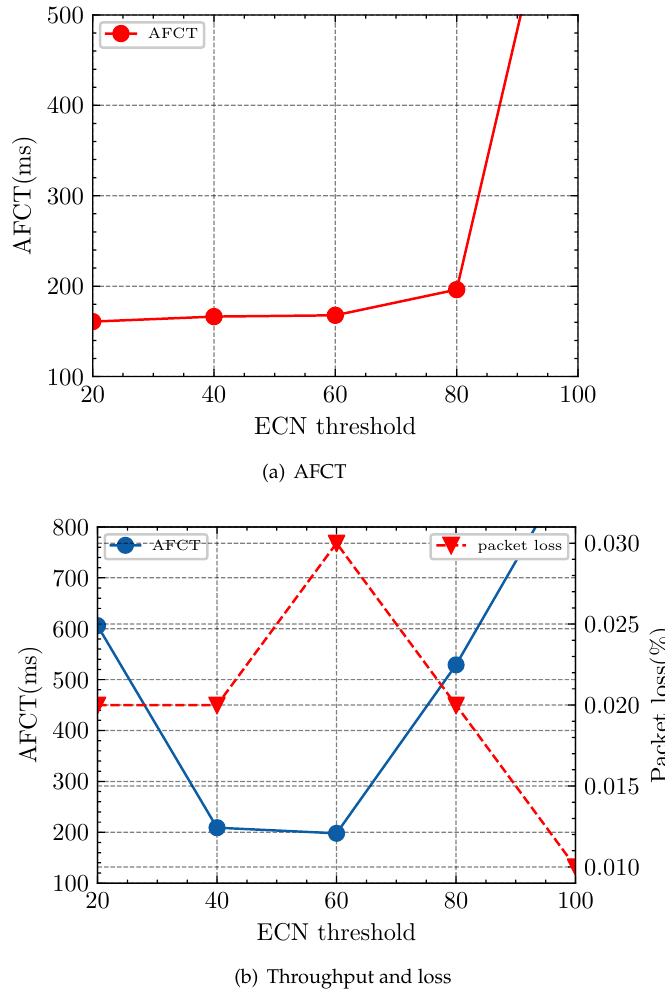
Figure 2. Incast environment, the impact of different ECN thresholds on short-flow AFCT, long-flow throughput, and network packet loss